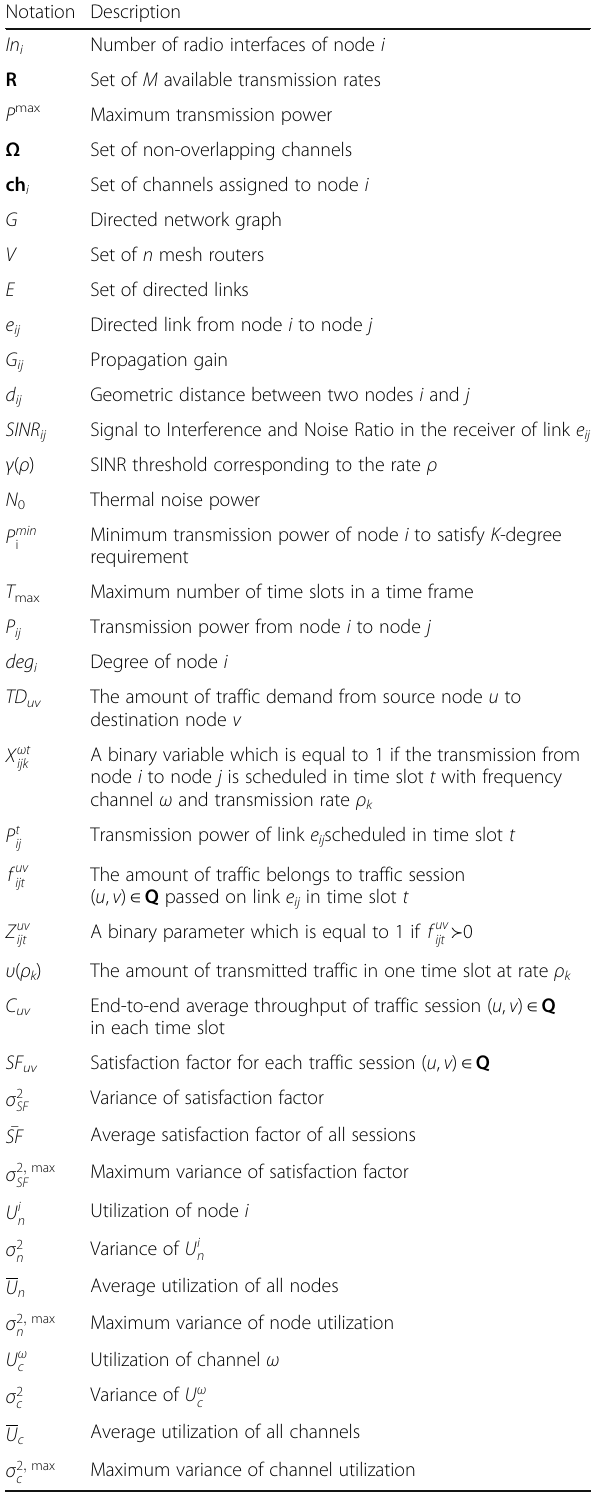
Table 1 List of some notations used in this paper Notation